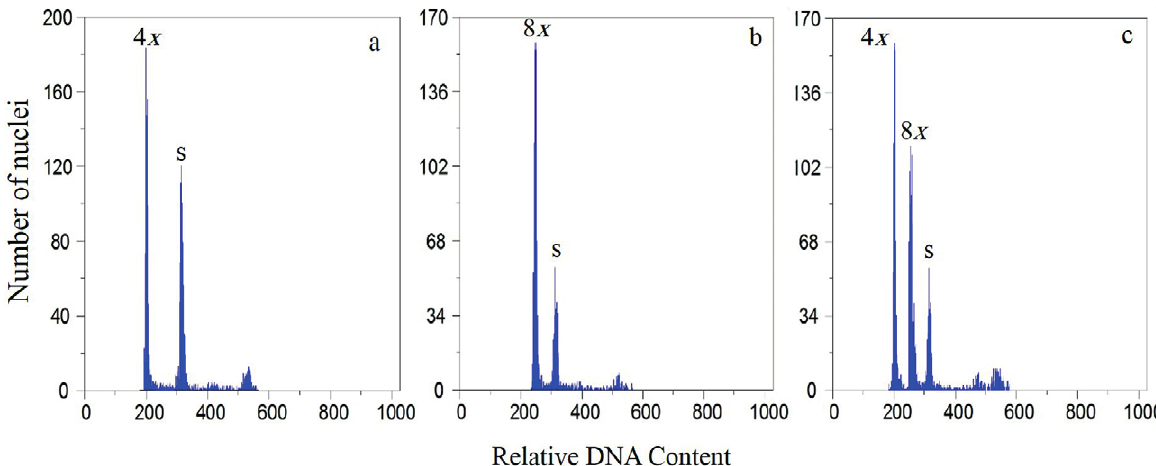
Figure 2. Flow cytometric histograms of nuclei isolated from in vitro-derived leaves of S. mutica tetraploid (a), octaploid (b), and mixoploid (c) plants. The right peaks (S) refer to the G1 of the standard maize reference plant ( Zea mays CE-777, 2C DNA = 5.43 pg), the left peaks (4x, 8x) refer to the G1 of tetraploid and octaploid plants, respectively.